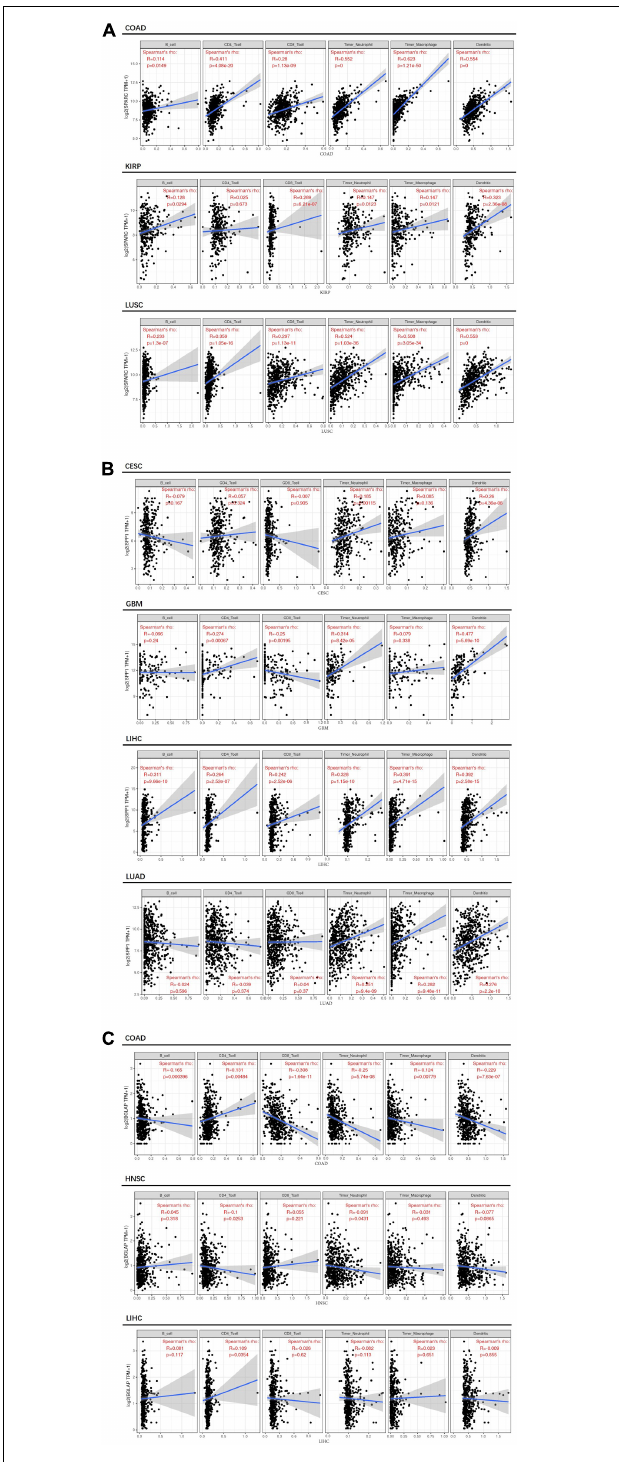
FIGURE 7 | Correlation between osteomimicry and immune cell infiltration in the cancer types in which osteomimicry indicated unfavorable survival. Results from TIMER demonstrated that SPARC (A) and SPP1 (B) expression were positively associated with infiltration of DCs and neutrophil cells in all study models. BGLAP (C) expression showed no prominent correlation with immune cell infiltration. p < 0.05 represents that difference is statistically